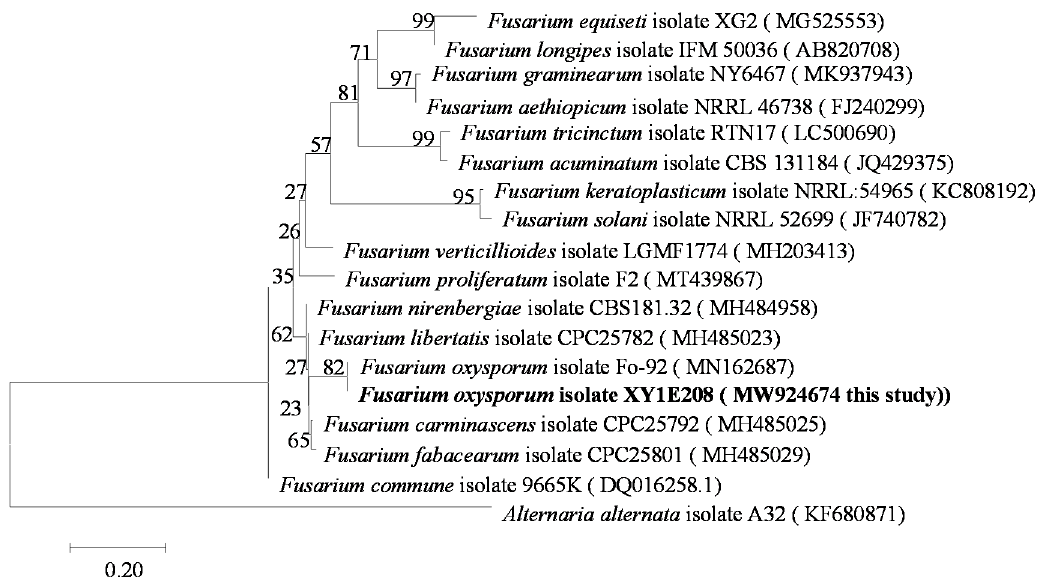
Figure 1. Phylogenetic tree for F. oxysporum based on translation elongation factor-1 α ( TEF-1 α ) gene sequences.